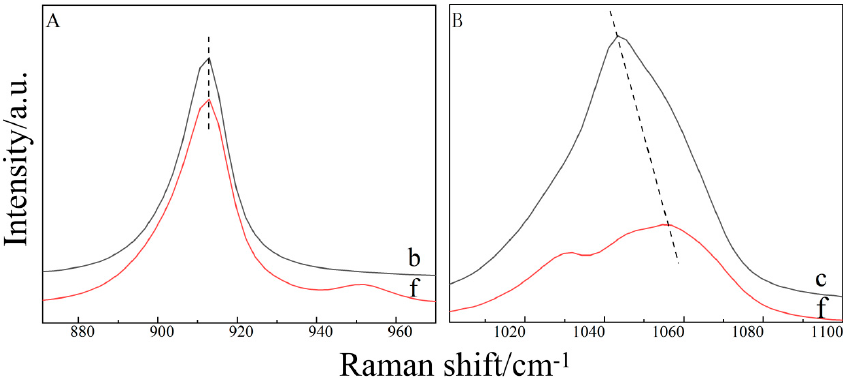
Figure 2. The Raman shift of C–O and S=O. ( A ) THF and THF–DMSO. ( B ) DMSO and